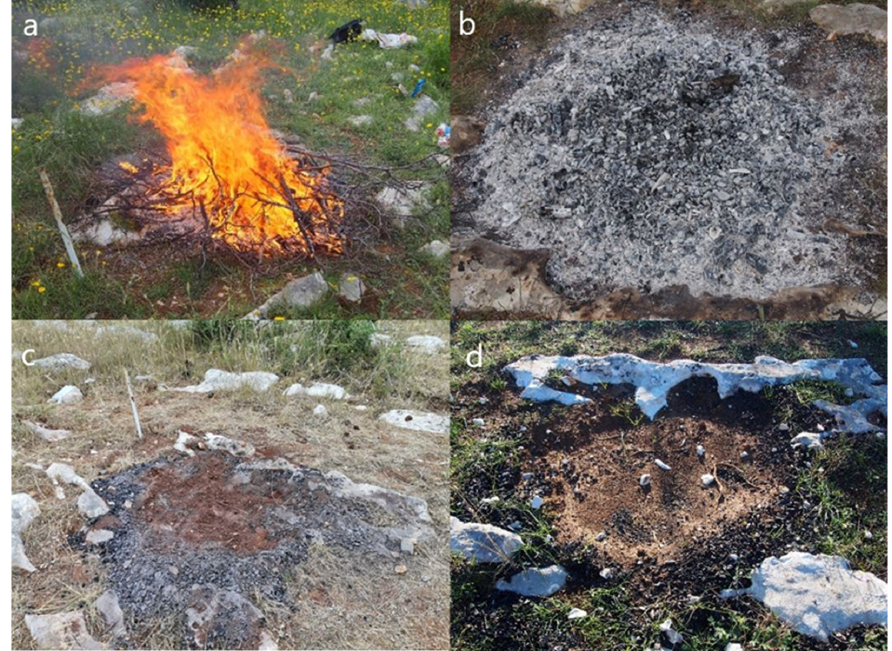
Figure 2. ( a ) Burn experiment, ( b ) immediately after the fire, ( c ) one month after the fire, ( d ) six months after fi re.